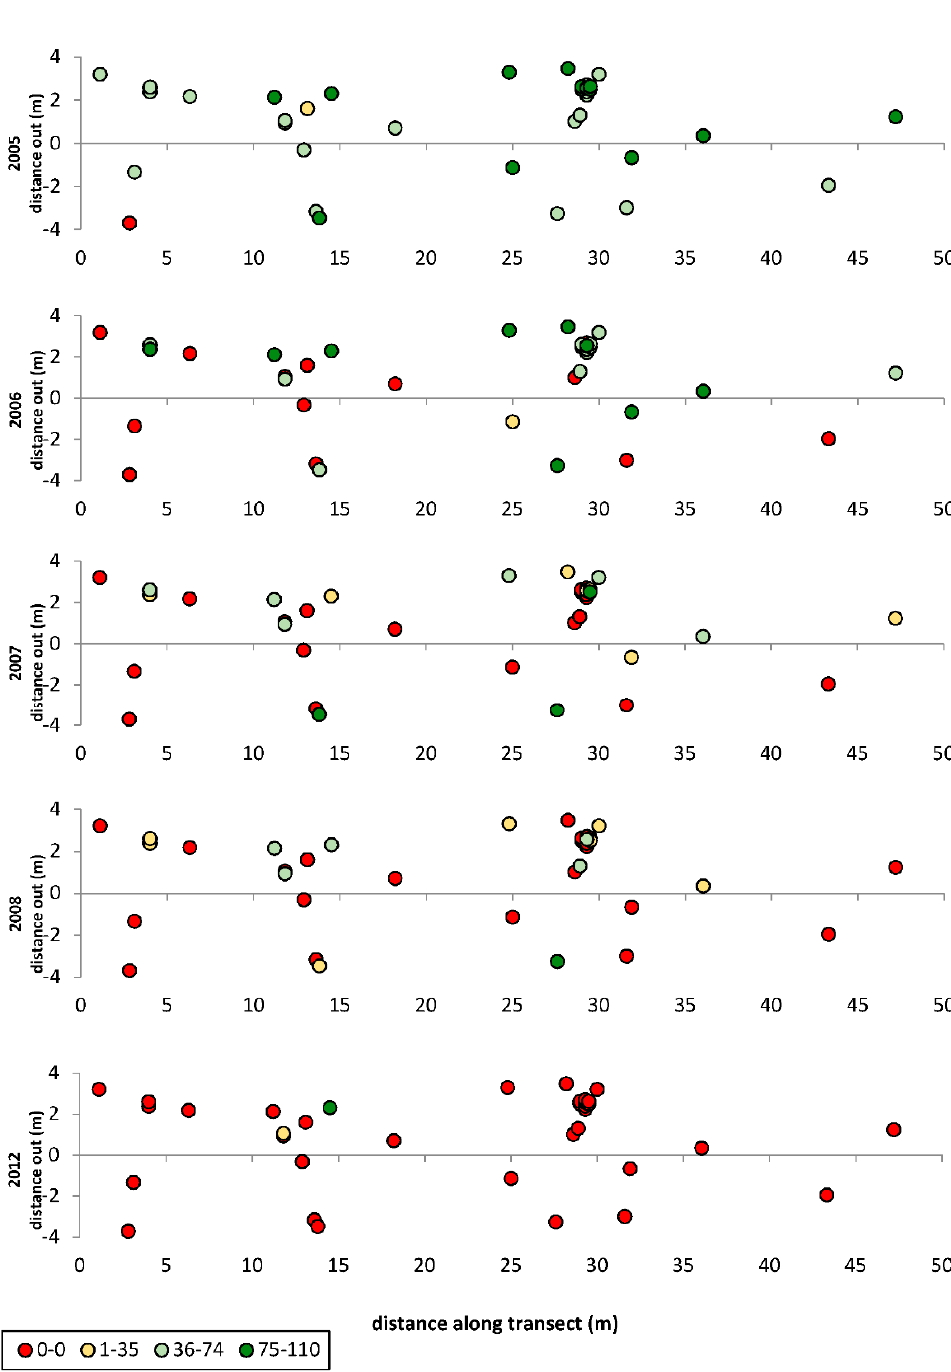
Figure 8. Transect 2, Individual Plant Health from June 2005 to June 2008 with a final rating in 2012. Figure 10. Transect 2, Individual seedling recruitment and health rating from June 2005 to June 2008 with a final rating in 2012. Health categories: = dead, = ratings 1–35, = ratings 36–74, = ratings 75–110.